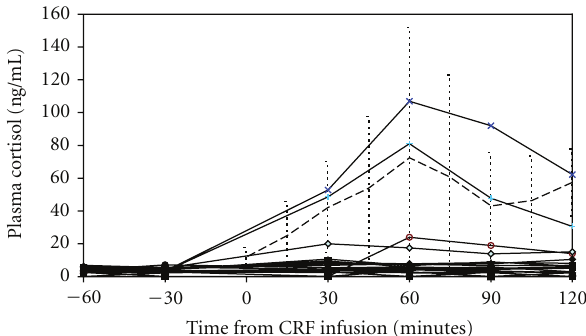
Figure 1: Dex-CRH Test in 20 patients. Each line shows the cortisol values for one patient. The dotted line shows the mean and 95% confidence interval for normal subjects previously reported [13].